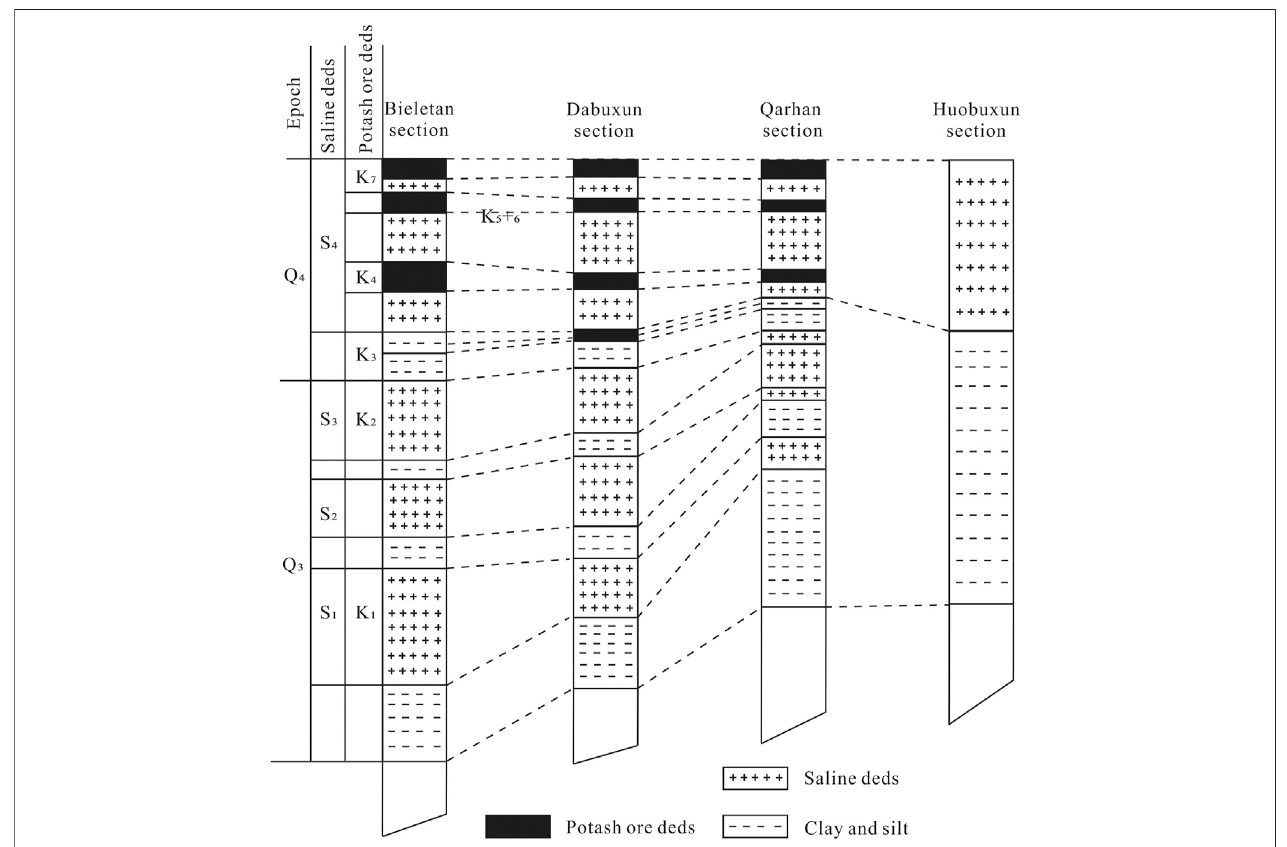
FIGURE 2 | Comparison sketch of the potash ore beds with saline beds in different sectors in Qarhan saline lake from Yang (1982).